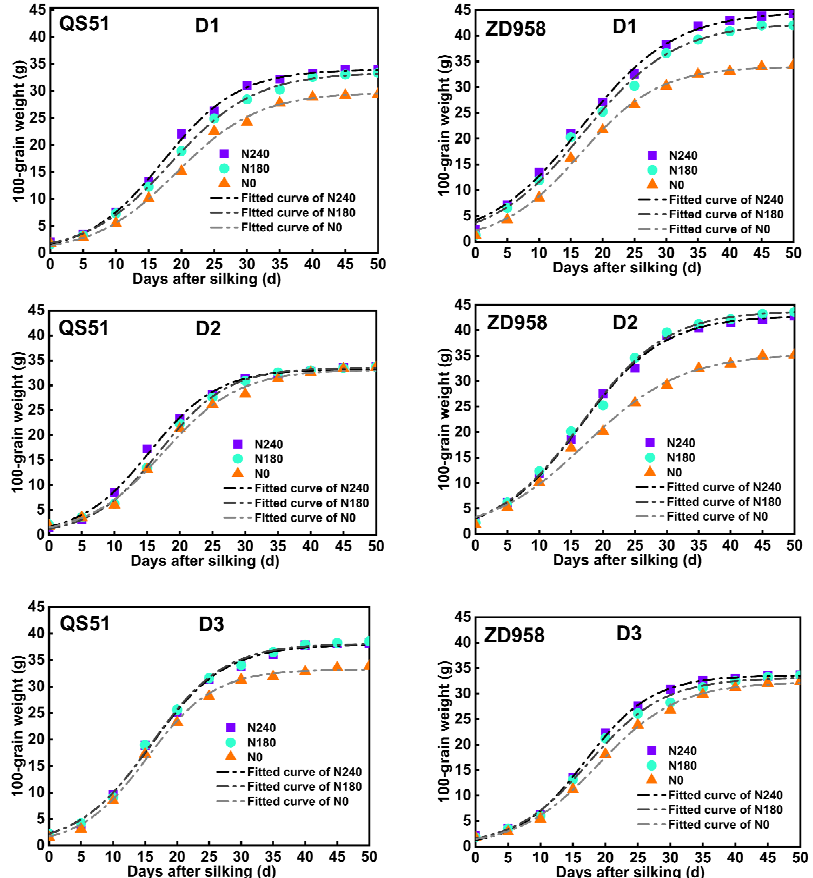
Figure 5. Dynamic changes of 100-grain weight for QS51 and ZD958. D1: 80,000 plants ha − 1 ; D2: 100,000 plants ha − 1 ; D3: 120,000 plants ha − 1 ; N0: no N application; N180: 180 kg N ha − 1 ; N240: 240 kg N ha − 1 .